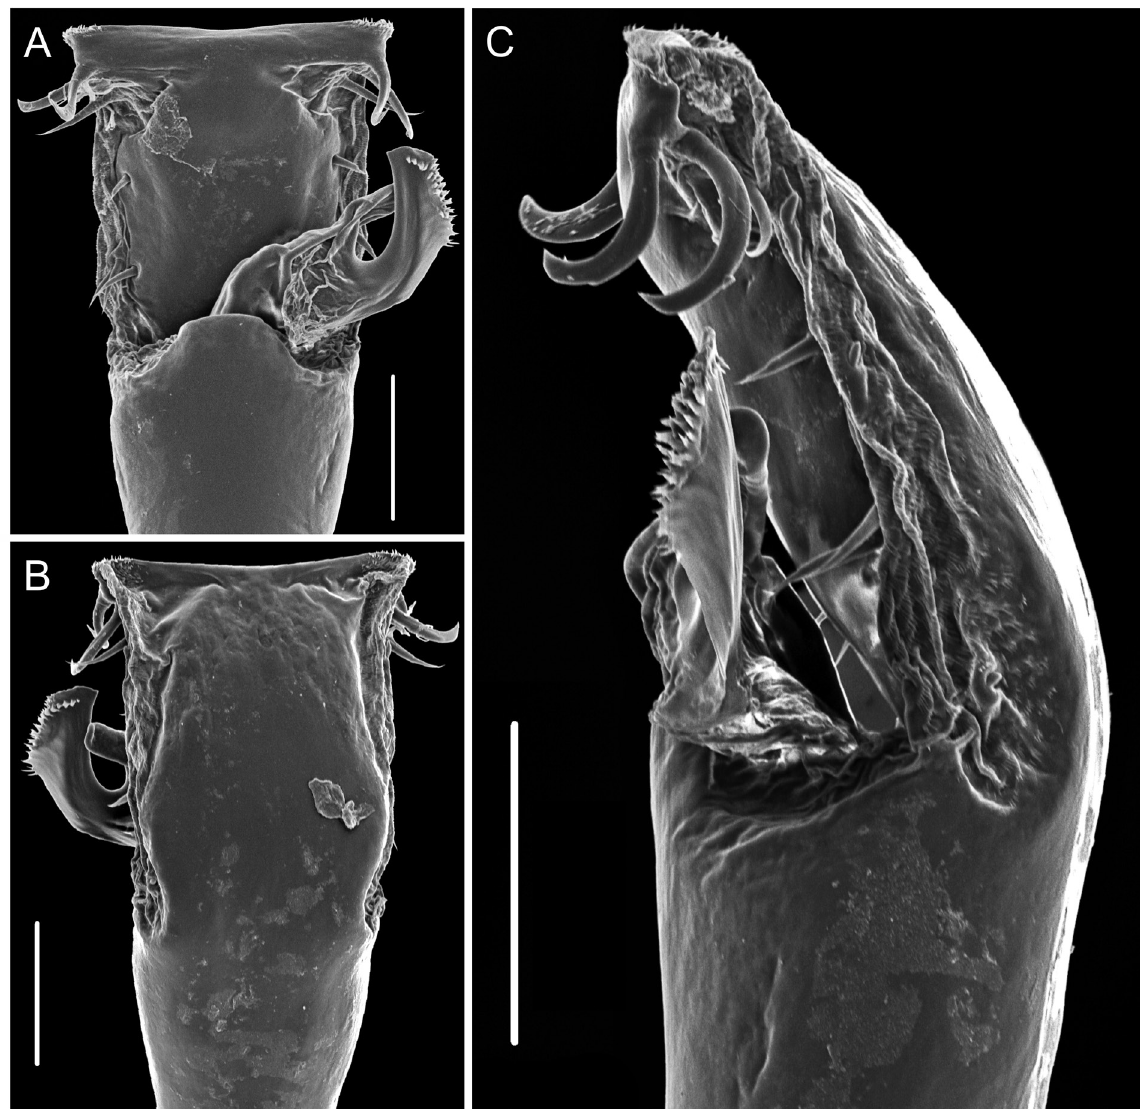
Fig. 22. Eulibitia maculata Roewer, 1912, ♂ (ICN-AO 875, different specimen than used in Fig. 2A–B), distal part of penis. A . Dorsal view. B . Ventral view. C . Lateral view. Scale bars: 100